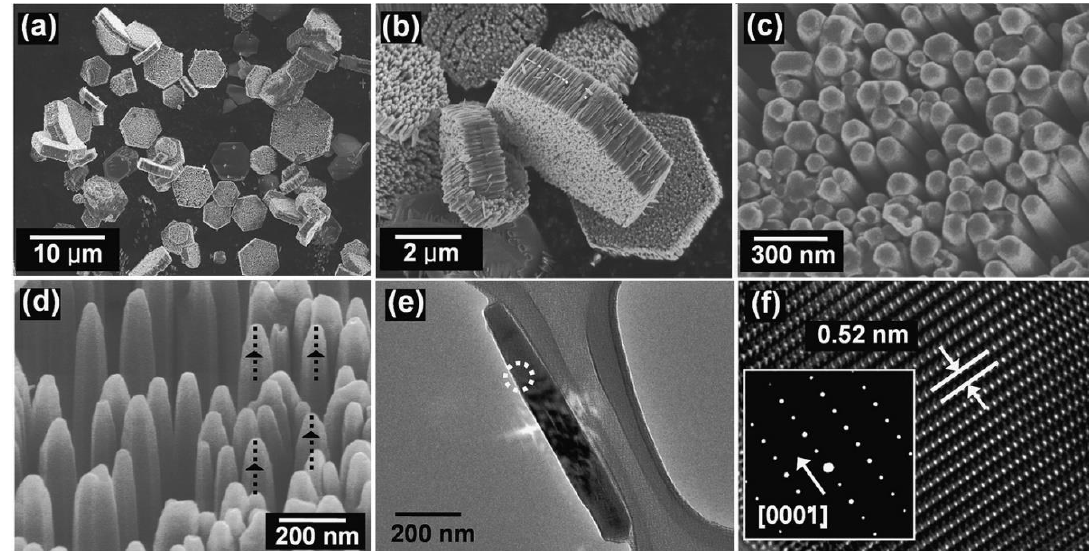
Figure 27. SEM images of hexagonal ZnO nanorod/zinc aluminium layered double hydroxide heterostructures: ( a ) low magnification; ( b ) medium magnification; ( c ) high magnification; ( d ) high-magnification oblique view image of ZnO nanorods grown on a zinc aluminium layered double hydroxide; ( e ) TEM image of a ZnO nanorod detached from a heterostructure; ( f ) High-resolution transmission electron microscopy (HRTEM) image of the point marked by the centre of the circle in ( e ). The inset is the SAED pattern. Republished with permission of © The Royal Society of Chemistry, from [723], Copyright (2009), permission conveyed through Copyright Clearance Center, INC. All rights reserved. In order to re-use permission must be obtained from the rightsholder.